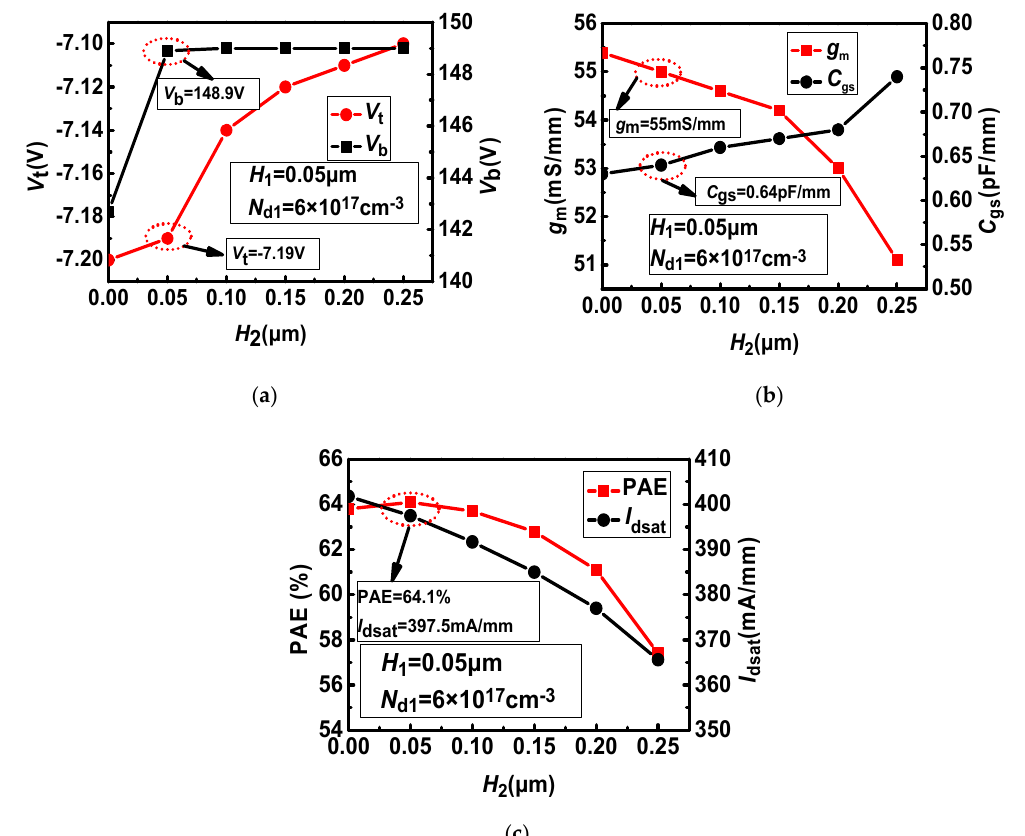
Figure 5. The effect of H 2 on the device parameters: ( a ) V t , V b – H 2 , ( b ) g m , C gs – H 2 , ( c ) PAE, I dsat – H 2 .